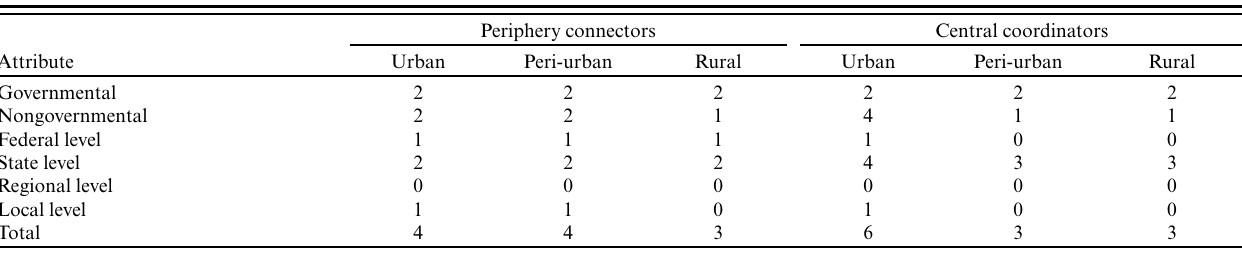
Table 1 . Number of periphery connectors and central coordinators per region and by type (governmental/nongovernmental) and jurisdictional